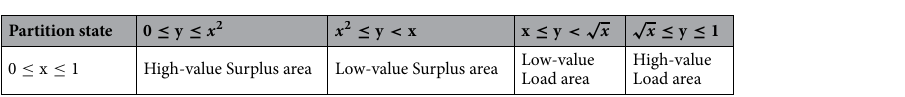
Table 4. Significance of the partition of the coupling mechanism between the support index and the pressure